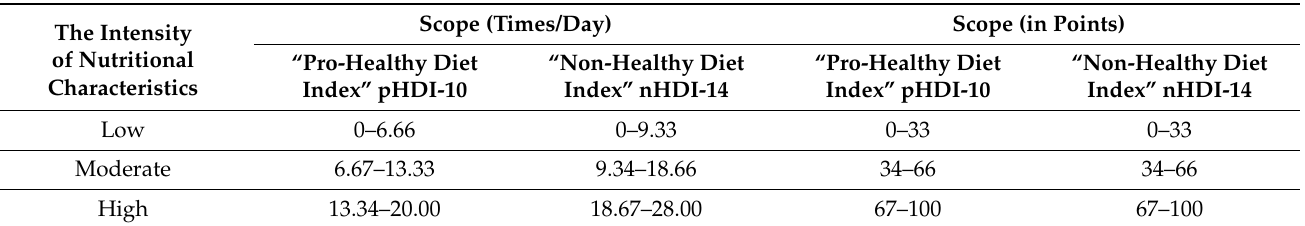
Table 1. Proposed interpretation of the “Pro-Healthy Diet Index” (pHDI-10) and the “Non-Healthy Diet Index” nHDI-14) for the KomPAN Questionnaire [34].